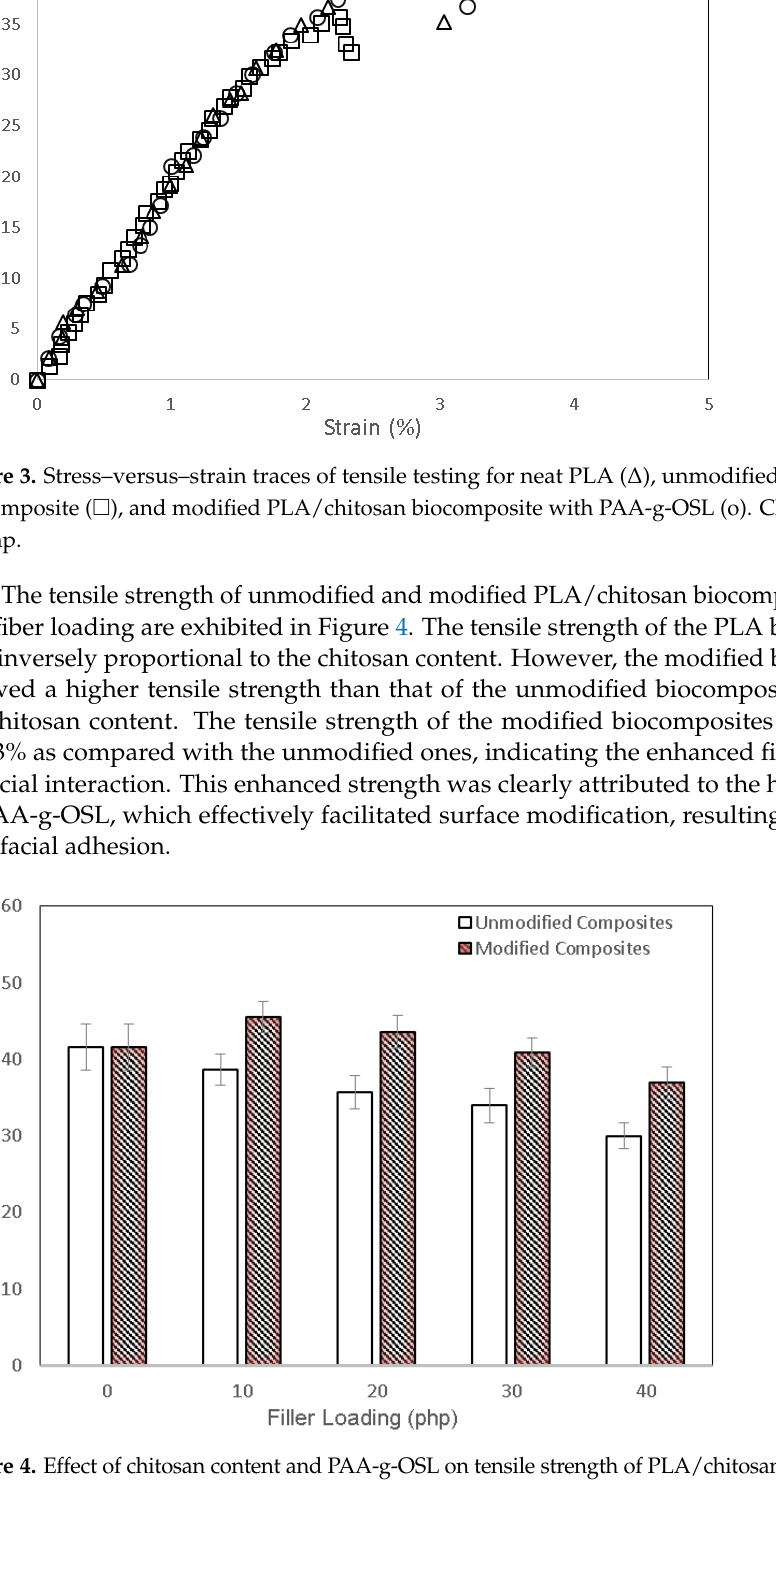
Figure 4. Effect of chitosan content and PAA-g-OSL on tensile strength of PLA/chitosan biocom- posites.